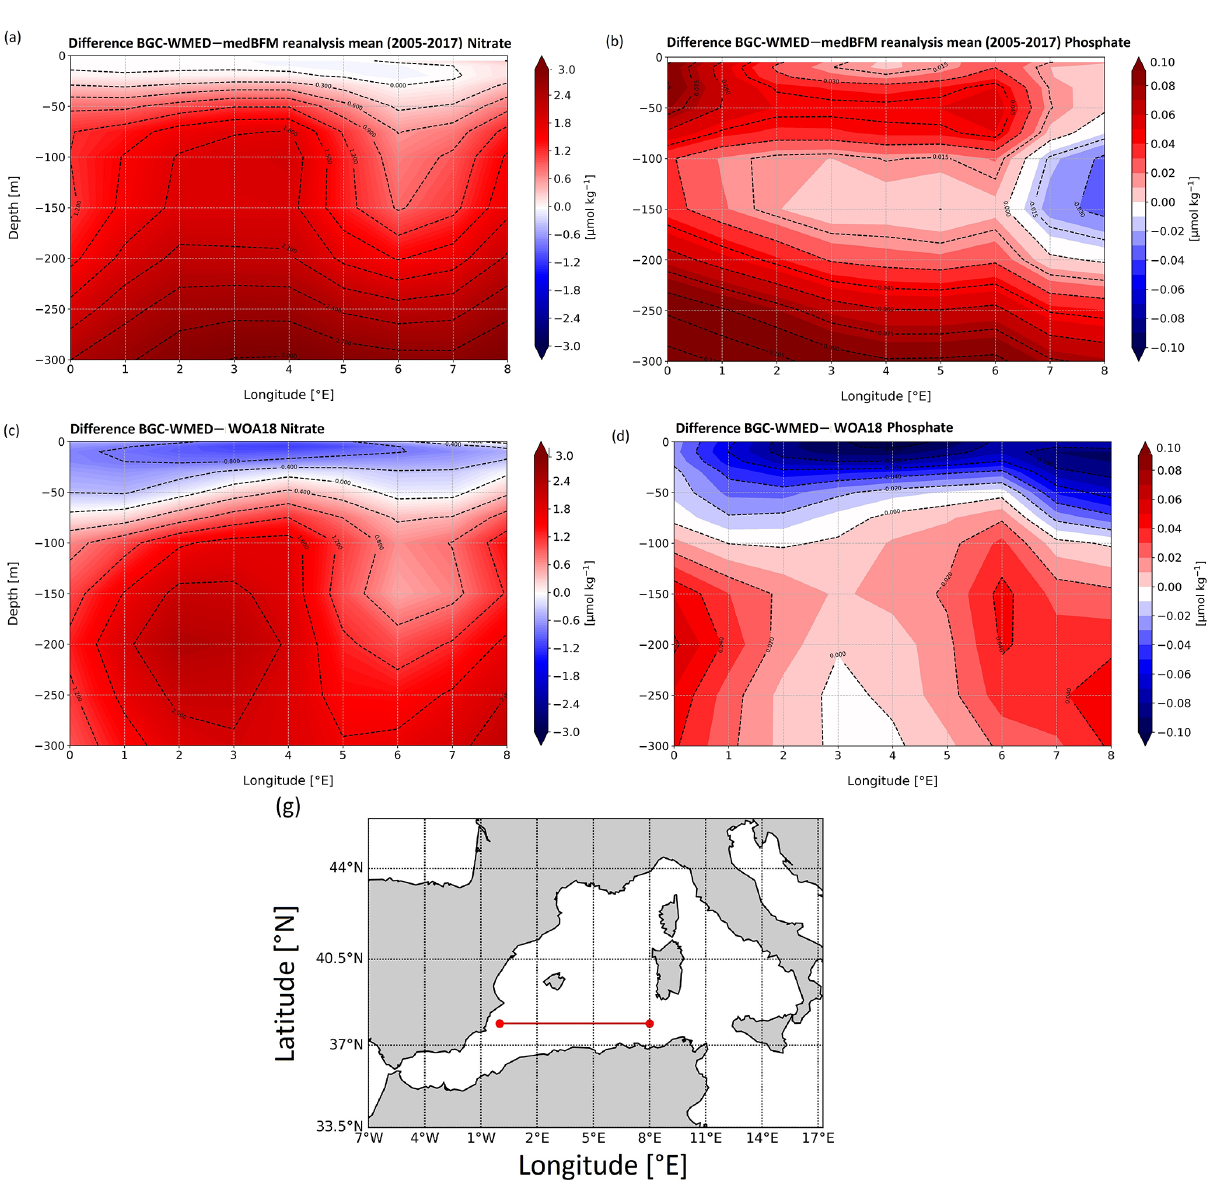
Figure 17. Difference in the vertical section from the Algerian Basin between the BGC-WMED and MedBFM ( a nitrate, b phosphate) and BGC-WMED and WOA18 ( c nitrate, d phosphate), with dashed contour lines and